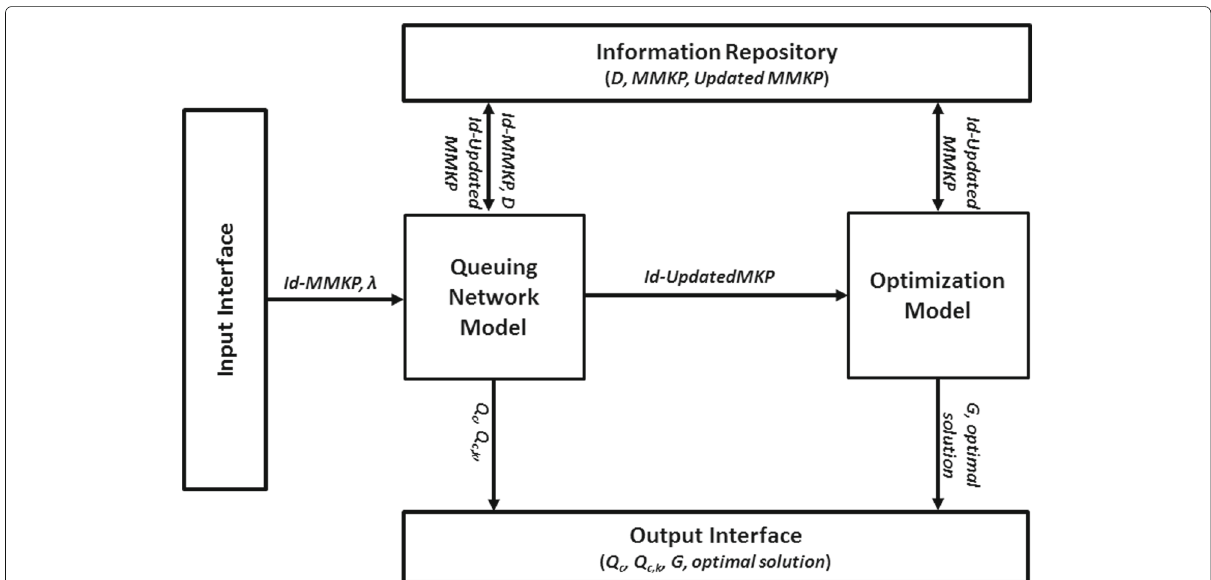
Fig. 6 optimalArch : architecture for implementing a decision support system based on the model-based